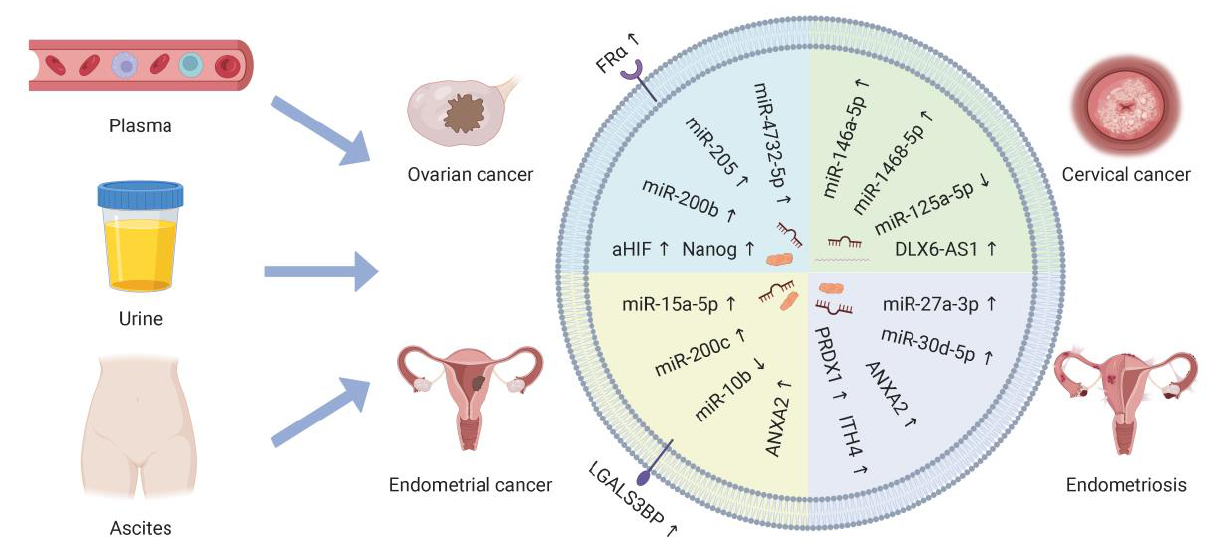
Figure 1. Sources and contents of small extracellular vesicles (sEVs) for liquid biopsy in gynecologic malignancies. These contents are potential biomarkers that can provide information about tumor progression, prognosis, and response to therapy [7]. The up or down arrows indicate the increase or decreasein sEV contents in the corresponding pathological states, respectively (Created with https://www.biorender.com/ (accessed on 26 February 2023)).